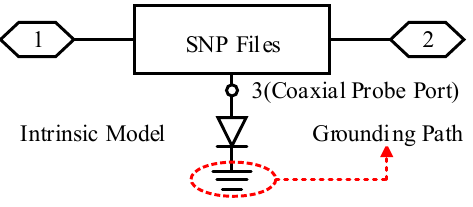
Figure 6. A 3-D EM model of a diode based on MCPT (port 3 represents a coaxial probe port; the SNP file is a model design file in TouchStone file format).